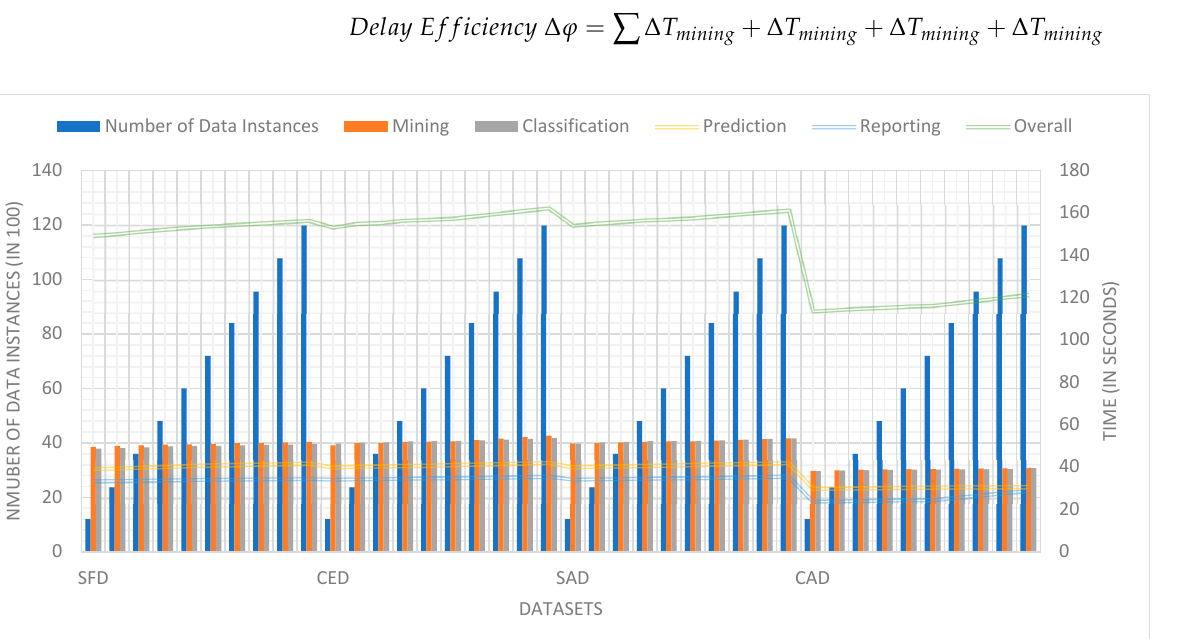
Figure 7. The prediction efficiency analysis.